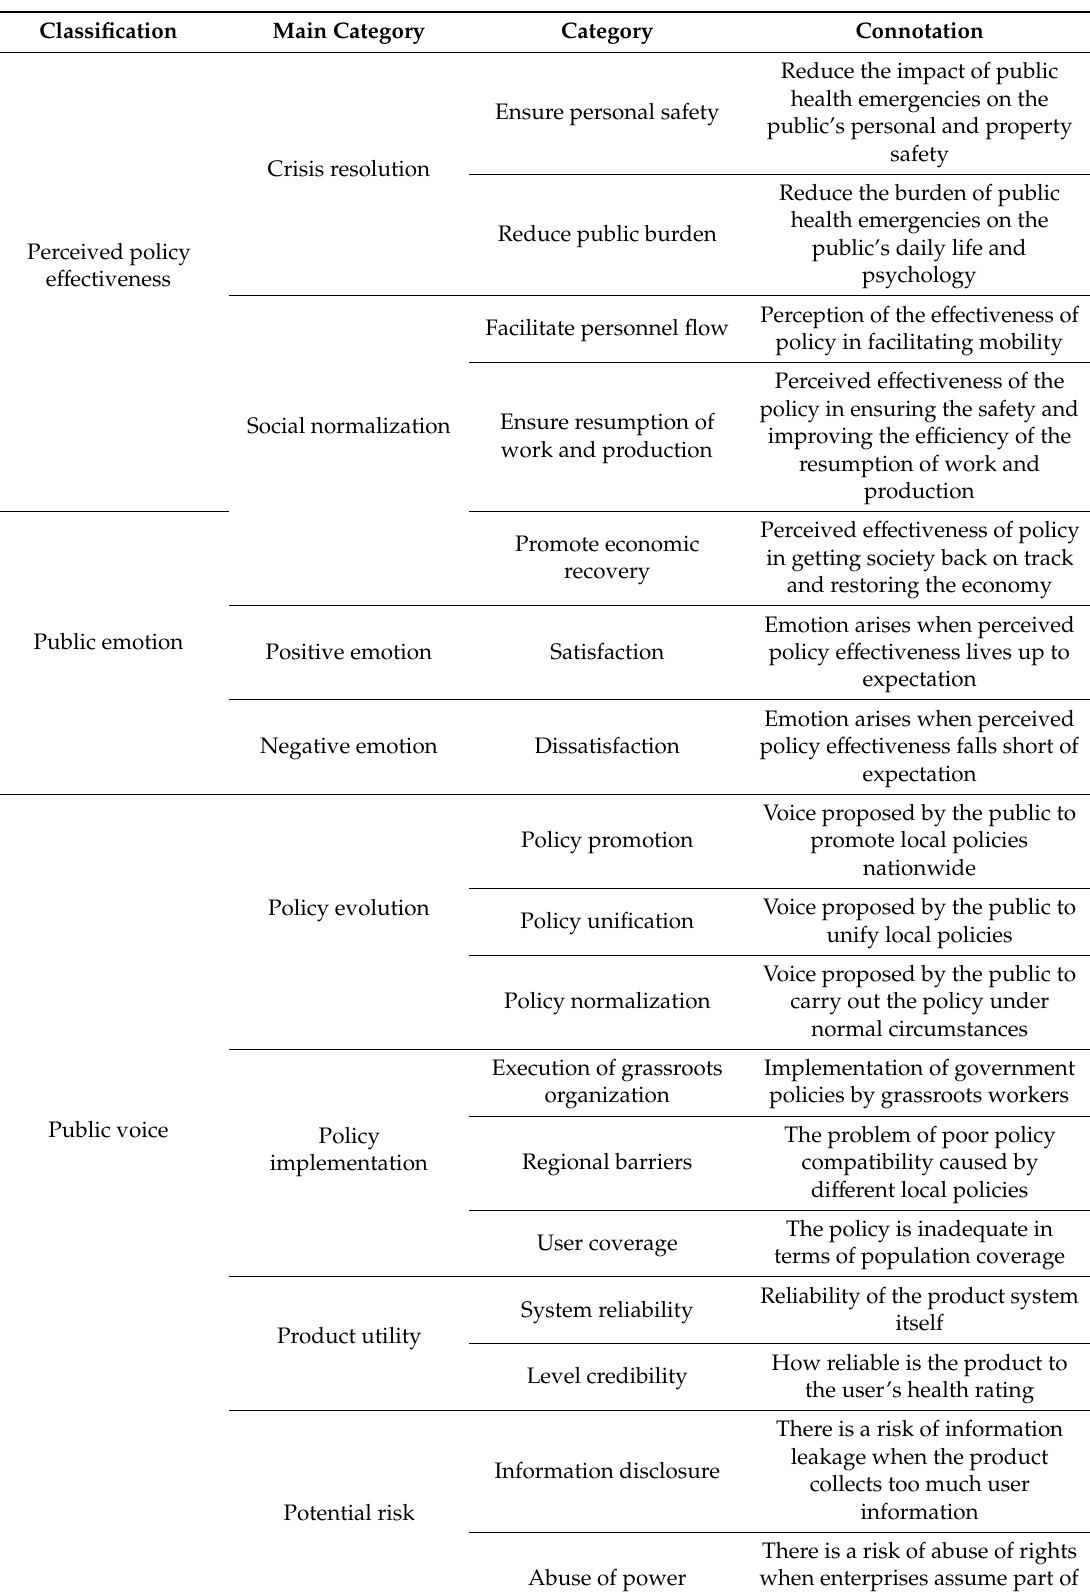
Table 2. Axial coding and analysis